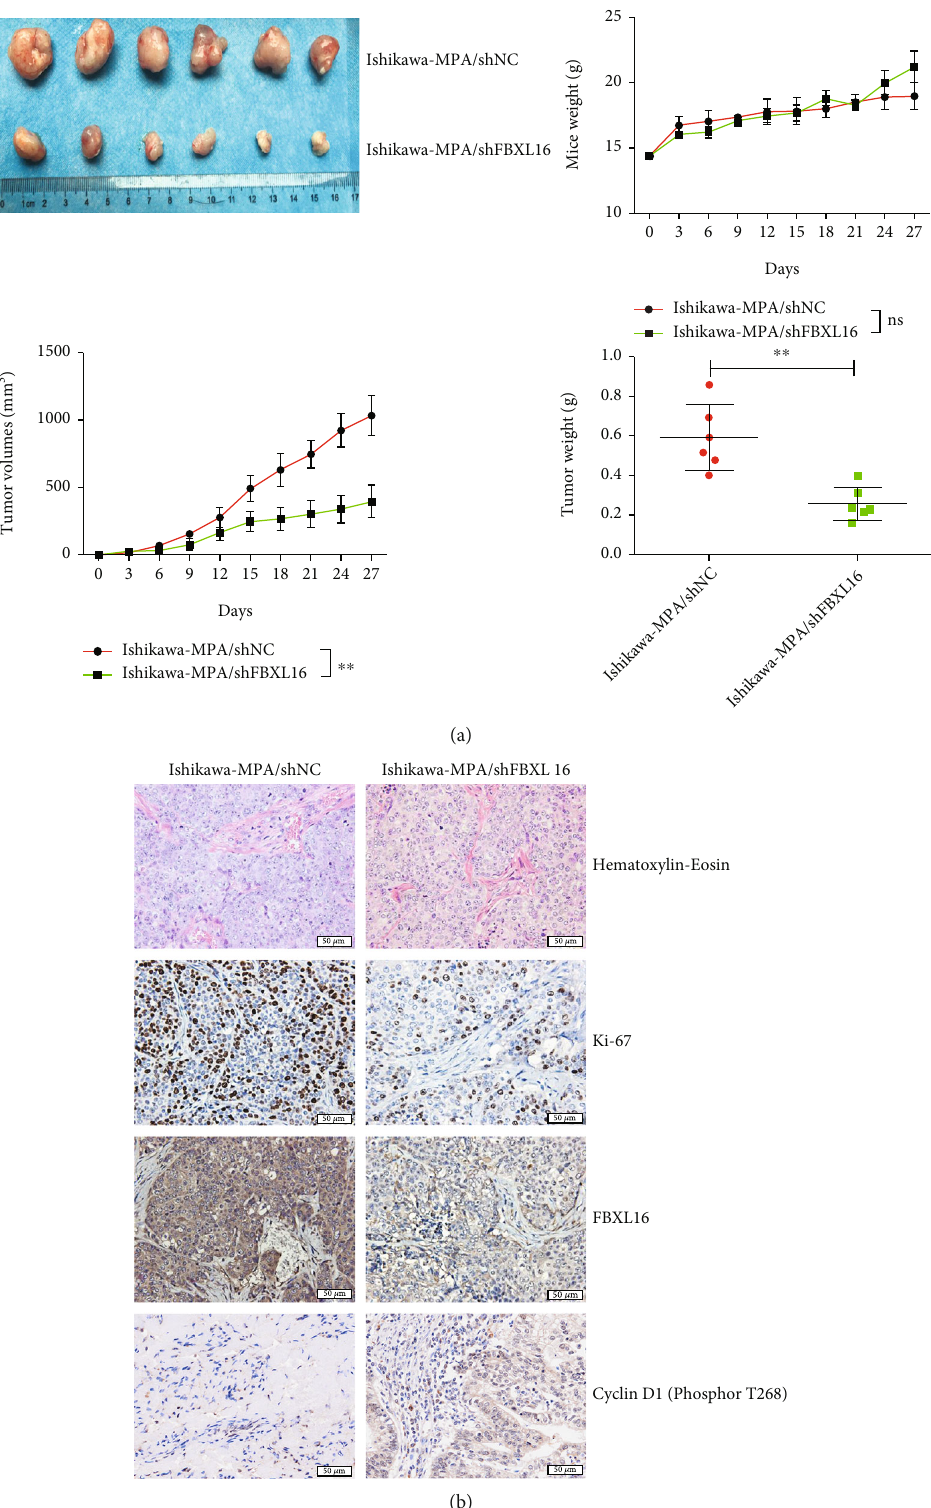
Figure 5: FBXL16 promotes MPA resistance and proliferation of endometrial cancer tumors in vivo. (a) The xenografts from nude mice inoculated in Ishikawa-MPA/shNC and Ishikawa-MPA/shFBXL16 cells. The tumor volumes in nude mice and mouse weight were determined for 27 days. Mean tumor weights at day 27 were determined. (b) H-E staining and IHC analysis of Ki-67, FBXL16, and phosphor-cyclin D1 (T268) were performed in the tumor tissue sections of Ishikawa-MPA/shNC and Ishikawa-MPA/shFBXL16. Data are represented as mean ± SD ( n = 5 per